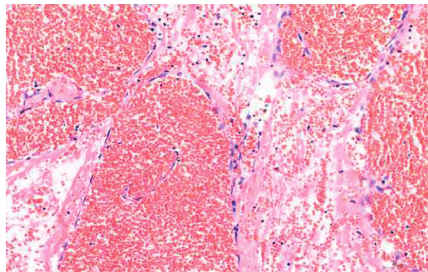
Figure 5: Microscopically, a typical adrenal cavernous hemangi- oma, including several dilated interconnecting vascular channels with thrombosis (hematoxylin and eosin staining × 200, original